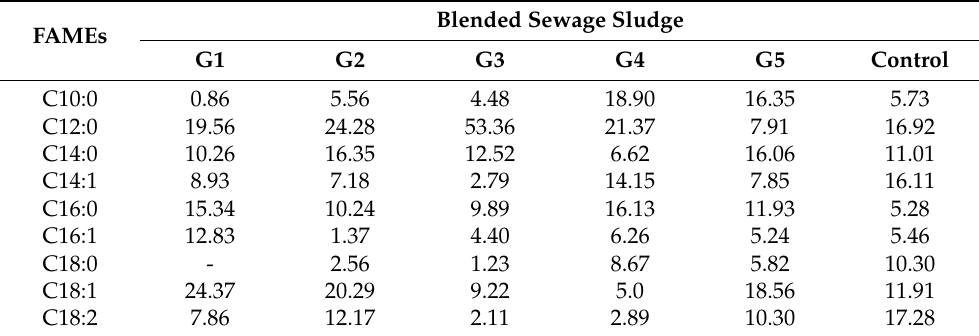
Table 2. Percentage of FAME content of BSFL-derived biodiesel fed with various ratio of blended sewage sludge.